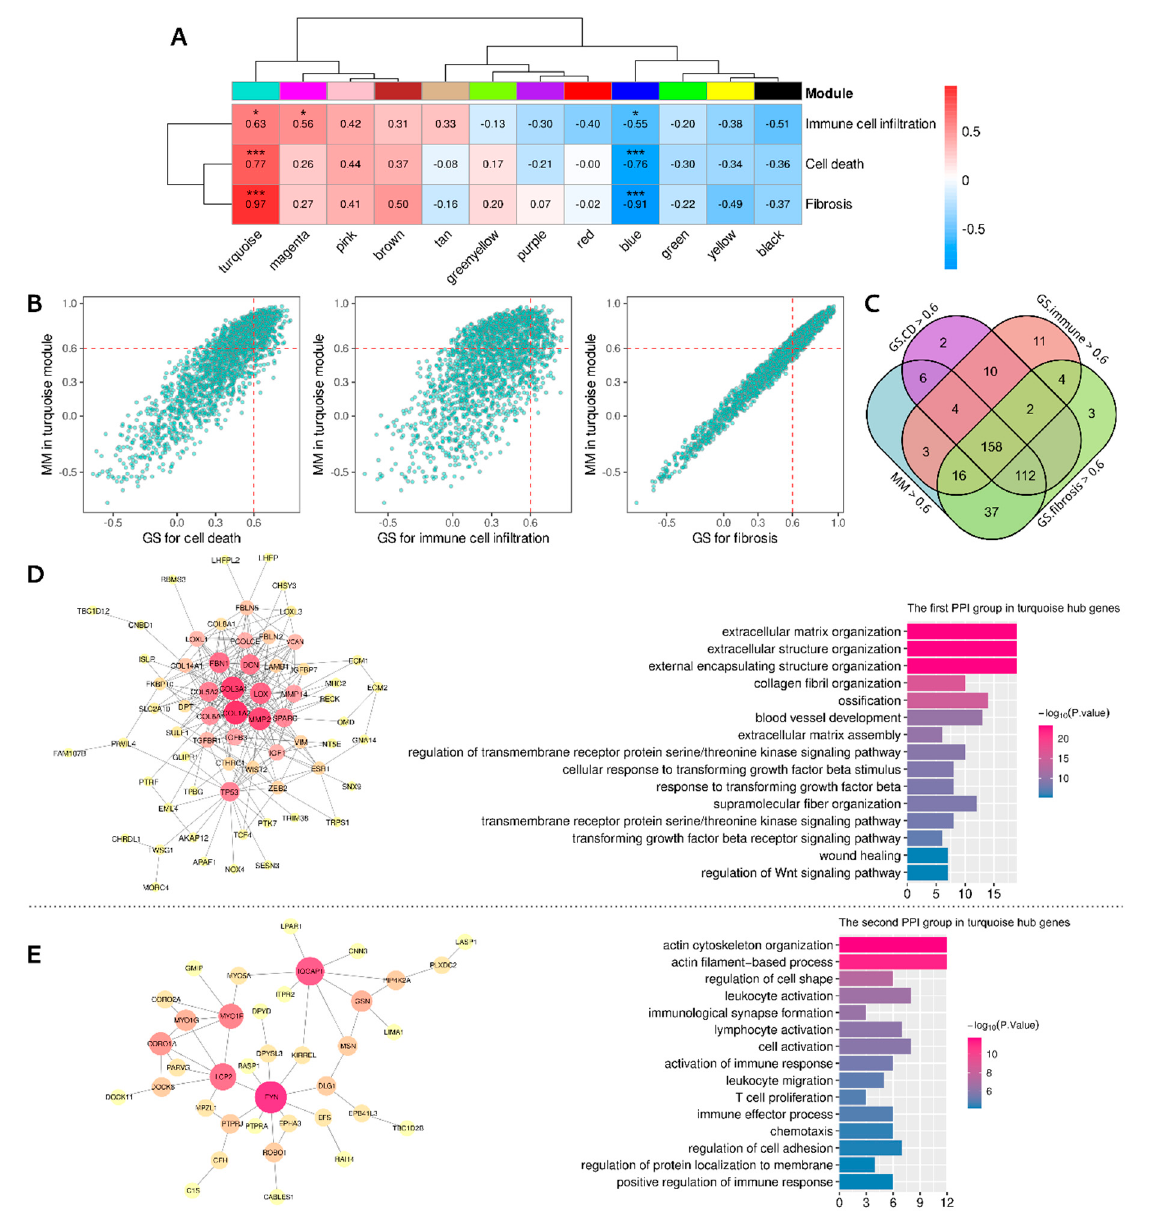
Figure 6. Weighted gene coexpression network analysis identified the shared correlated module.